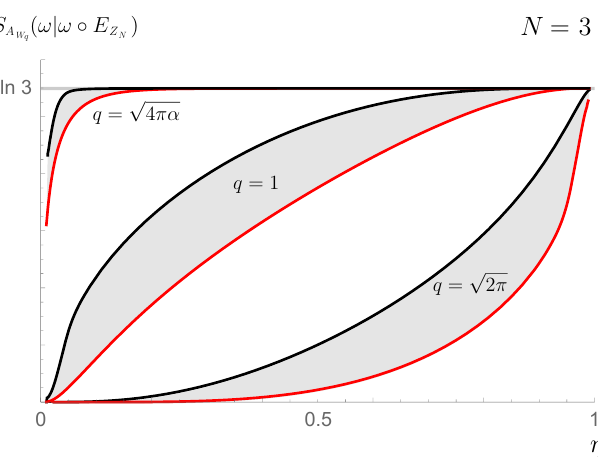
( ω | ω ◦ E ) with N = 3 for 3 different Z N √ Wq 2 π